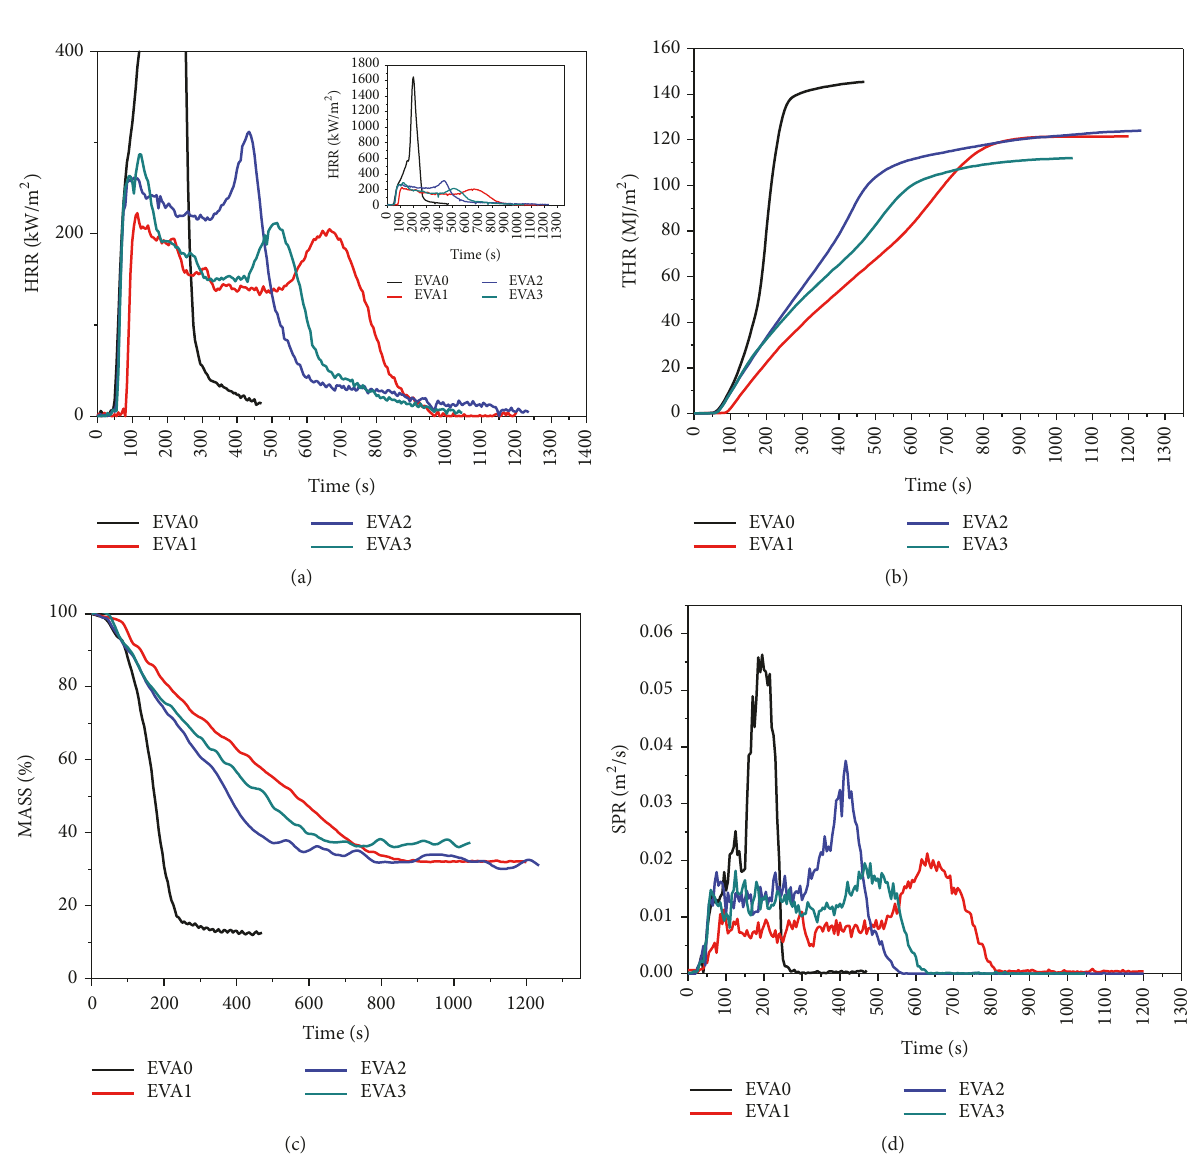
Figure 5: Cone curves of EVA/LDHs composites ((a) HRR, (b) THR, (c) mass, and (d)